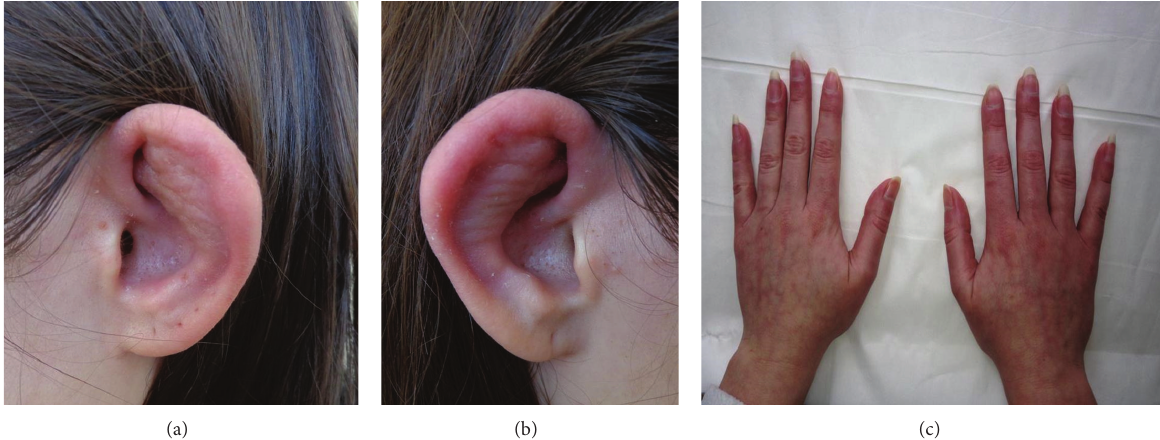
Figure 1: (a, b) Cauliflower ears. Swelling and erythema of the cartilaginous part of the ear, sparing the lobule which lacks cartilage. (c) The Raynaud’s phenomenon.